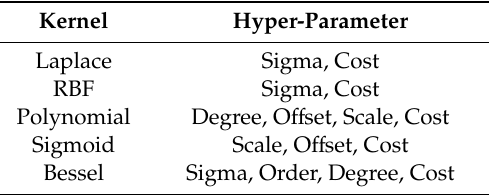
Table 5. Applied SVR kernels [54].